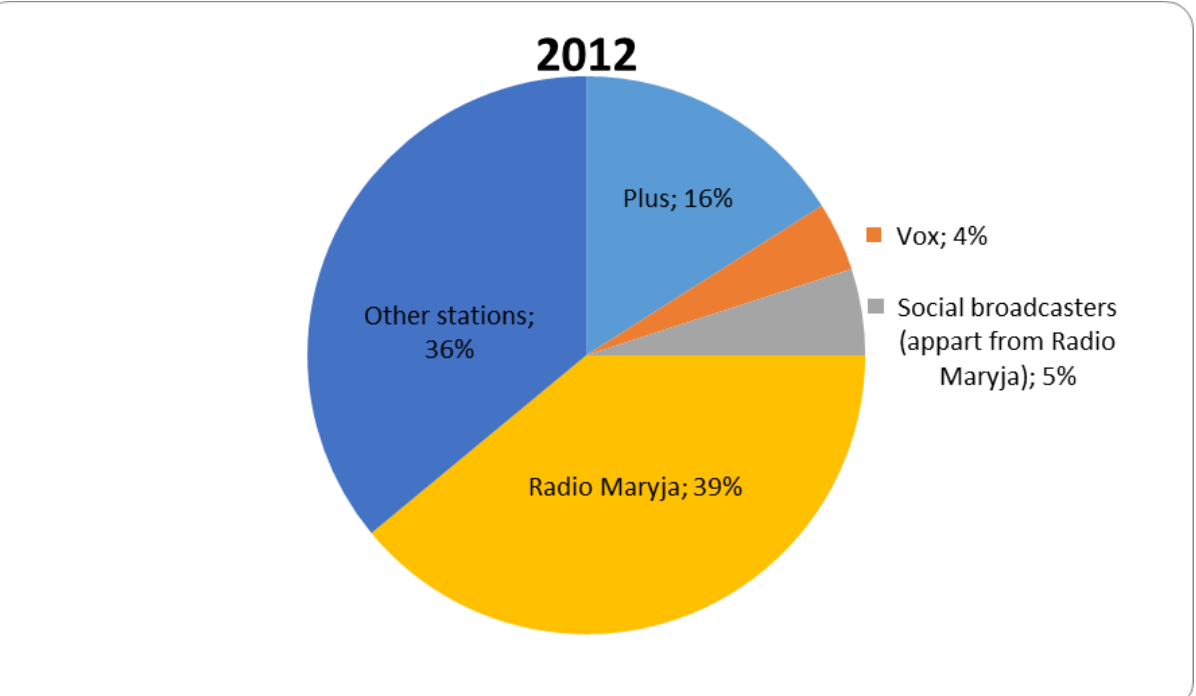
Figure 1. The incomes of religious broadcasters from the advertising market, subsidies and donations together in 2012. Source: National Broadcasting